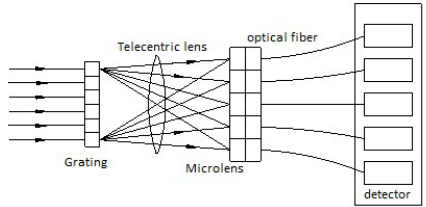
Figure 1 overall system design